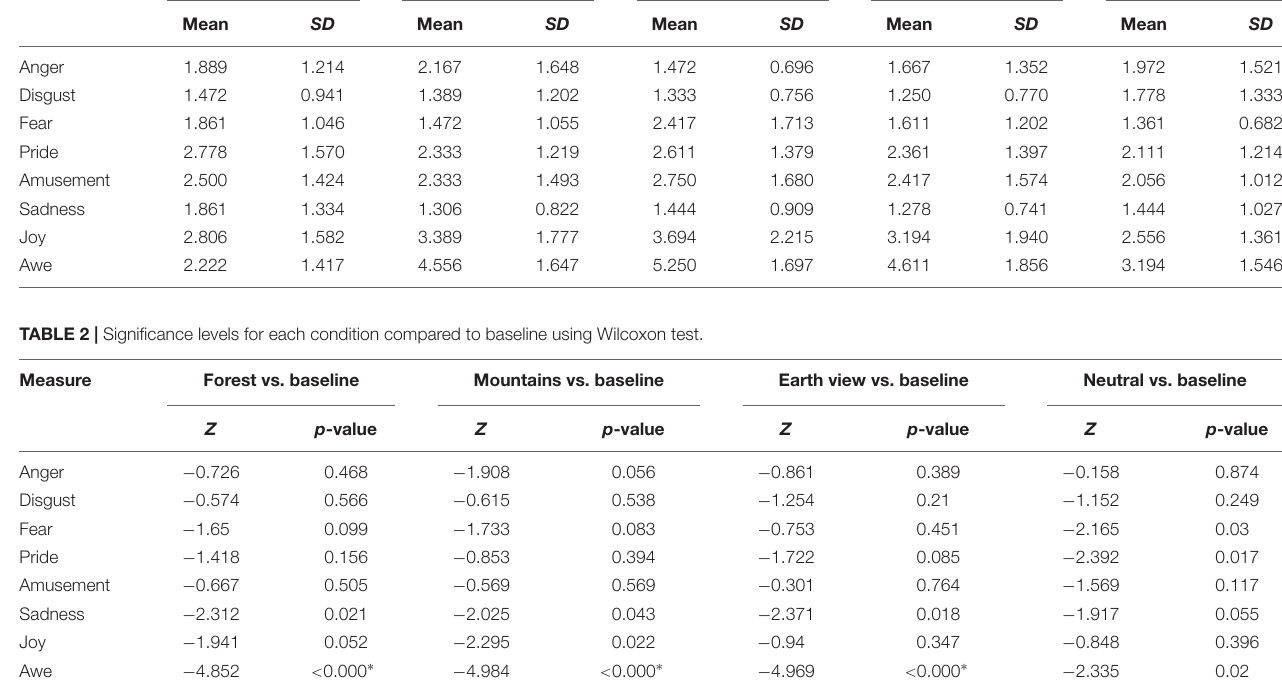
TABLE 1 | Emotions scores for each condition: mean and standard deviation for each emotion in each condition. Measure Baseline Forest Mountains Earth view